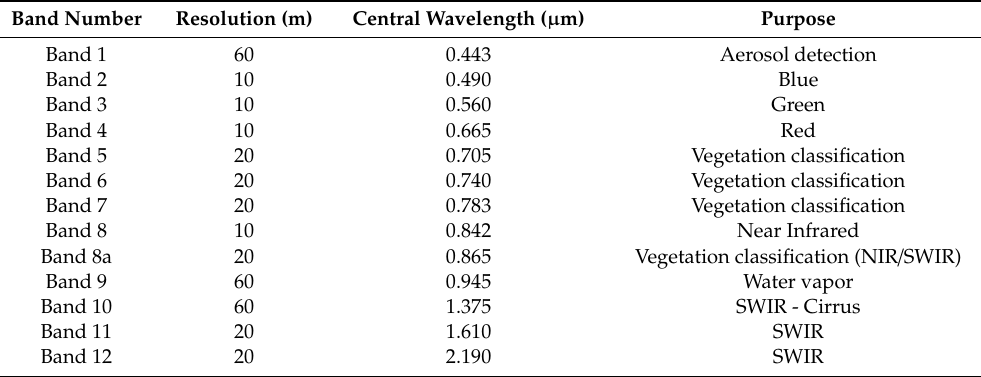
Table 1. Wavebands of MSI sensor onboard of SENTINEL-2